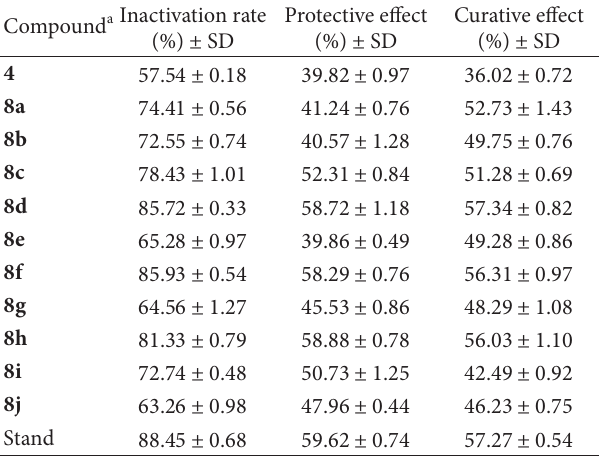
Table 2: The inhibitory activity of the titled urea and thiourea derivatives 8(a–j) on